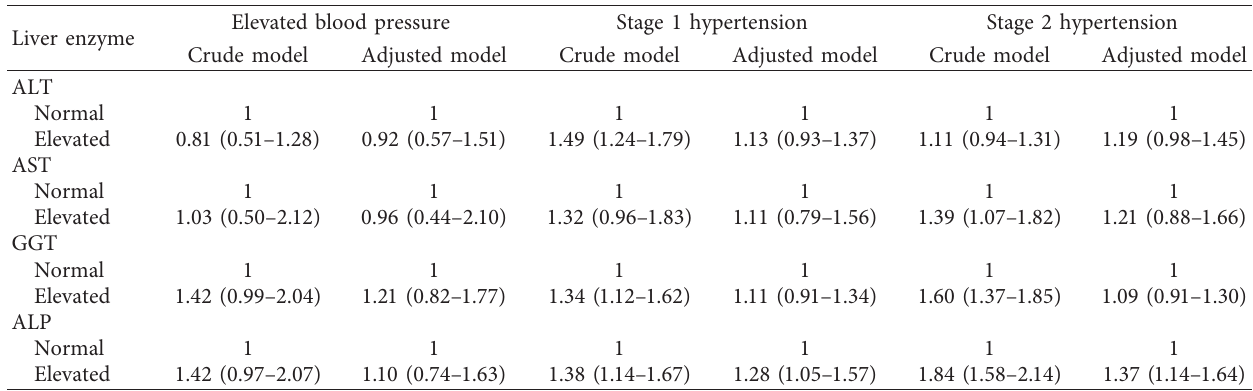
Table 5: Association of the serum levels of liver enzymes with elevated blood pressure, stage 1 hypertension, and stage 2 hypertension in study participants ( n � 9991).